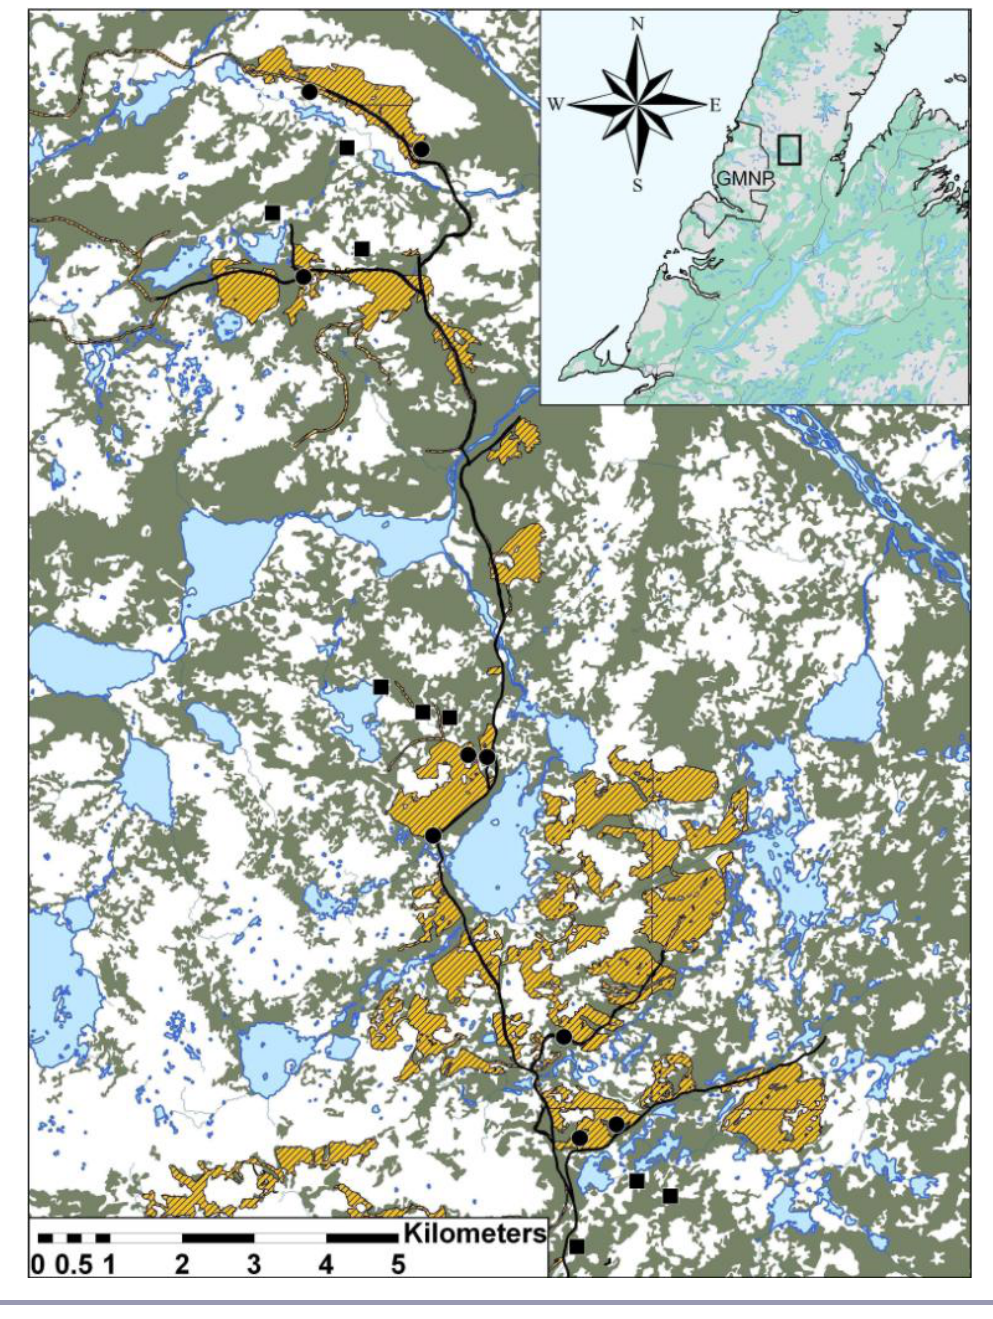
Fig. 1. Distribution of netting sites across three paired landscapes in the Upper Main River watershed, 2003-2006. Each landscape included three netting sites located in areas having forest cover broken either by natural openings (squares) or by clearcuts (circles). Productive forest cover (green) was interspersed with clearcuts (hatched orange), scrub forest and peatlands (white), and lakes and rivers (blue). The rectangle in the inset map depicts the location of the study area, east of Gros Morne National Park (GMNP) on the island of Newfoundland,